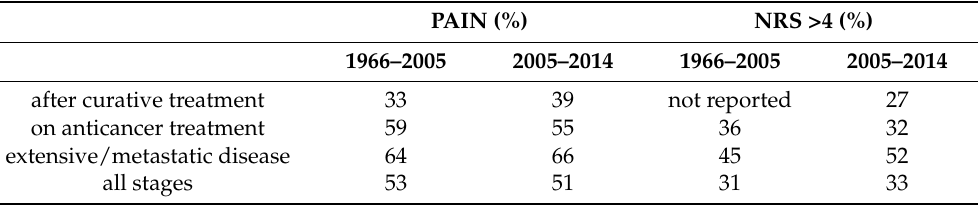
Table 1. Prevalence of pain in patients with